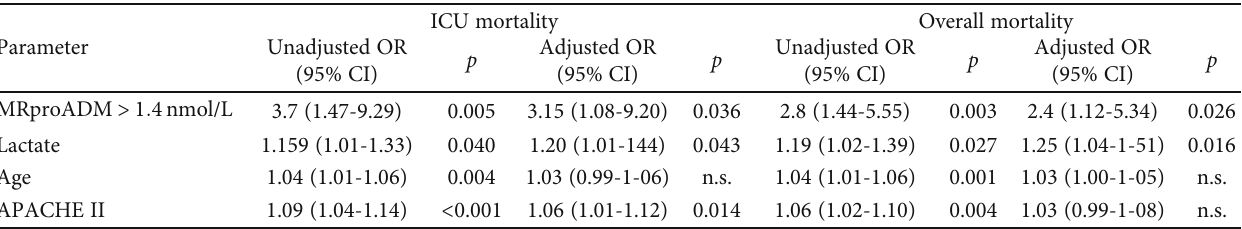
Table 5: Uni- and multivariate logistic regression analyses for MRproADM levels at ICU admission to predict ICU and overall mortality. ICU mortality Parameter